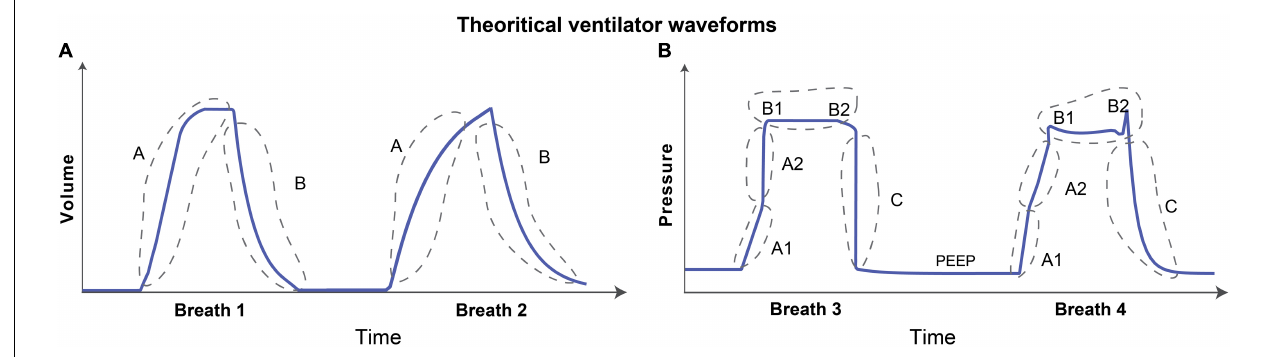
FIGURE 1 | Graphical representation of theoretical volume and pressure waveforms. (A) The volume signal generally has two distinct features. The rising and falling of the volume signal during inspiration and expiration, respectively, are denoted as features A and B. (B) The pressure signal can typically have multiple features in the waveform that contain useful information. The gradient of the rising signal in which pressure continues to increase during inspiration can have two distinct features, denoted as features A1 and A2. These two features define the gradient of the rising signal before and after the inflection point such that there may be abrupt increases (breath 1) or decreases (breath 2) in the signal gradient. The shape of the plateau pressure is captured using features B1 and B2 such that there may be a peak at the beginning (B1-breath 2) and/or at the end (B2-breath 2) of the plateau. Finally, the gradient of the falling signal is captured using feature C that represents the expiration process. The baseline pressure is known as positive end-expiratory pressure (PEEP), and often used in ARDS patients to maintain an open lung (Cavalcanti et al., 2017). Note that the breaths were drawn to highlight the features which might contain useful information about lung condition and ventilator-patient interaction when the respective variable is free. If the variable is controlled, e.g., volume during VCV, the waveform features represent ventilator